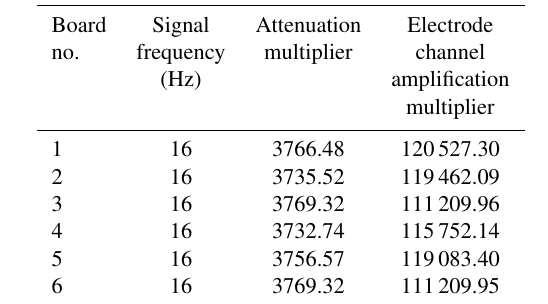
Table 1. Electrode channel